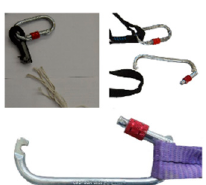
Figure 11. Lanyards connectors of post-test 14 ( top left ), 15 ( bottom ) and 16 ( top right ), respectively.